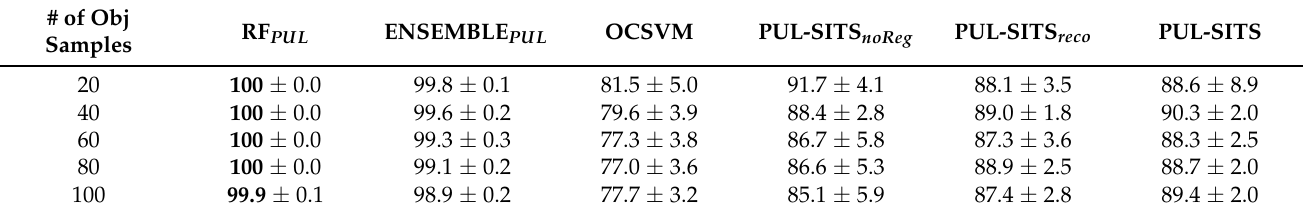
Table 6. Performances in terms of the Sensitivity of the different competing strategies when the land cover class of interest (the positive class) is Cereals/Oilseeds